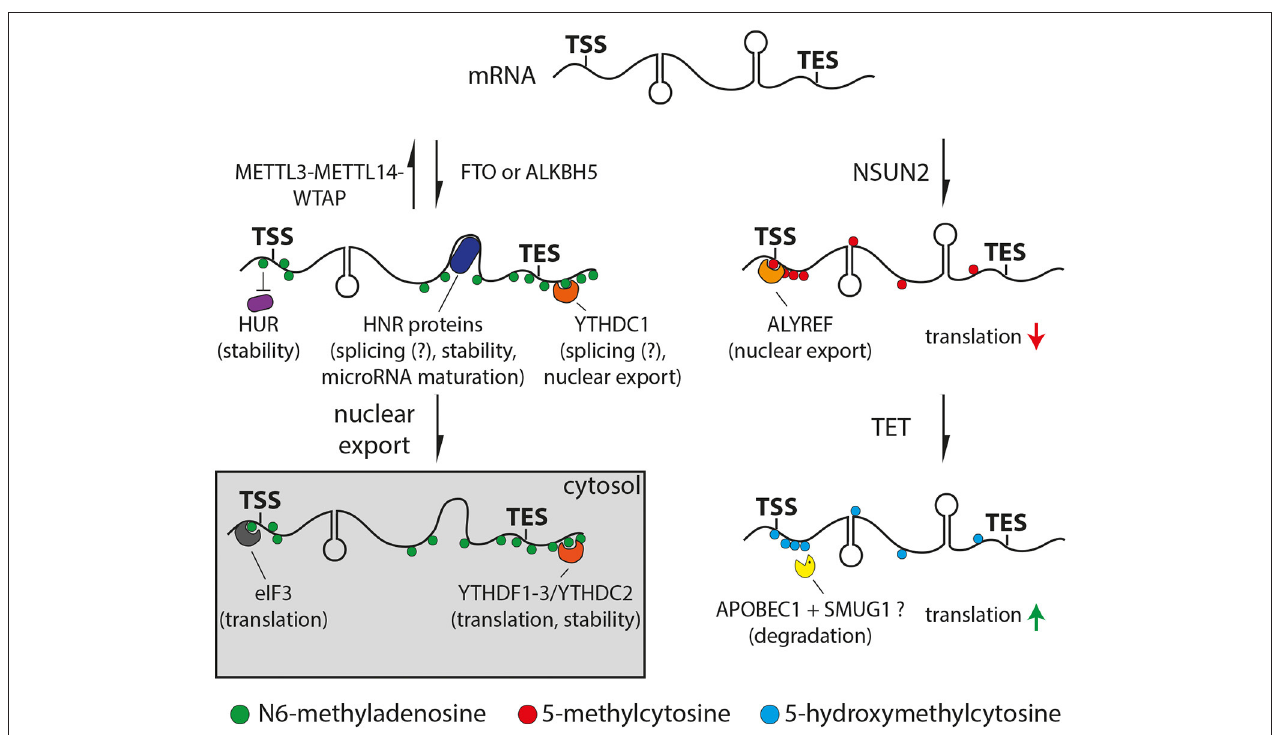
FIGURE 1 | Drawings of N6-methyladenosine (left) or 5-methylcytosine (right) pathways. Left: Adenosine is methylated (m6A, green) by the METTL3/METTL14/WTAP complex or removed by the FTO or ALKBH5 demethylases. Proteins can bind m6A directly (YTH and eIF3, orange and gray respectively), indirectly through changes in secondary structure (HNR, dark blue) or be repelled by m6A (HUR, purple). Right: Cytosine is methylated at the 5 position (5mC, red) by NSUN2 and oxidized to 5-hydroxymethyl- (5hmC) or 5-formylcytosine (light blue) by TET proteins. 5mC can recruit ALYREF (orange) decreasing translation efficiency, while 5hmC can enhance translation (red and green arrows, respectively). APOBEC1 and SMUG1 (yellow) may be involved in the removal of oxidized 5-methylcytosine resulting in the degradation of the cleaved mRNA. Potential functions of m6A or 5mC readers are indicated in